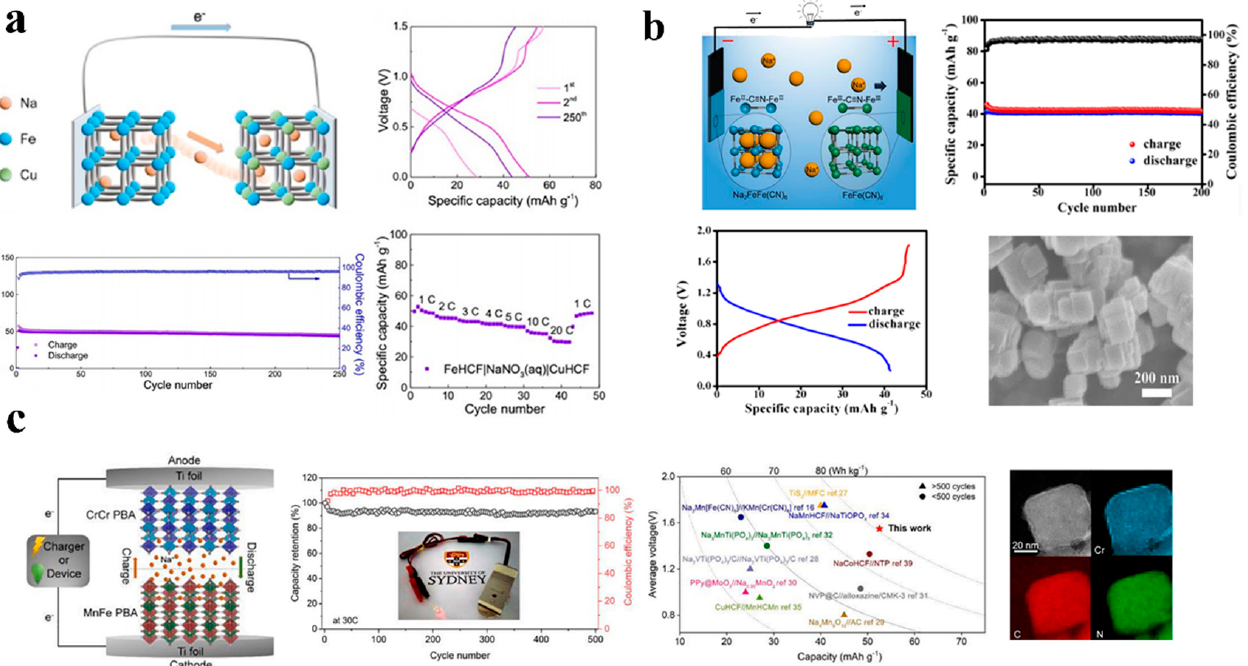
Figure 10. ( a ) Working principle and electrochemical performance of the full ASIB. Reproduced with the permission of ref. [92], copyright 2019 Wiley − VCH Verlag GmbH & Co. KGaA, Weinheim. ( b ) The characteristics of symmetric ASIBs with FeFe(CN) 6 as electrodes. Reproduced with the permission of ref. [93], copyright 2017 Wiley − VCH. ( c ) A schematic illustration of battery structure and the performance comparison with recently reported ASIBs. Reproduced with the permission of ref. [59], copyright 2021 Elsevier B.V.